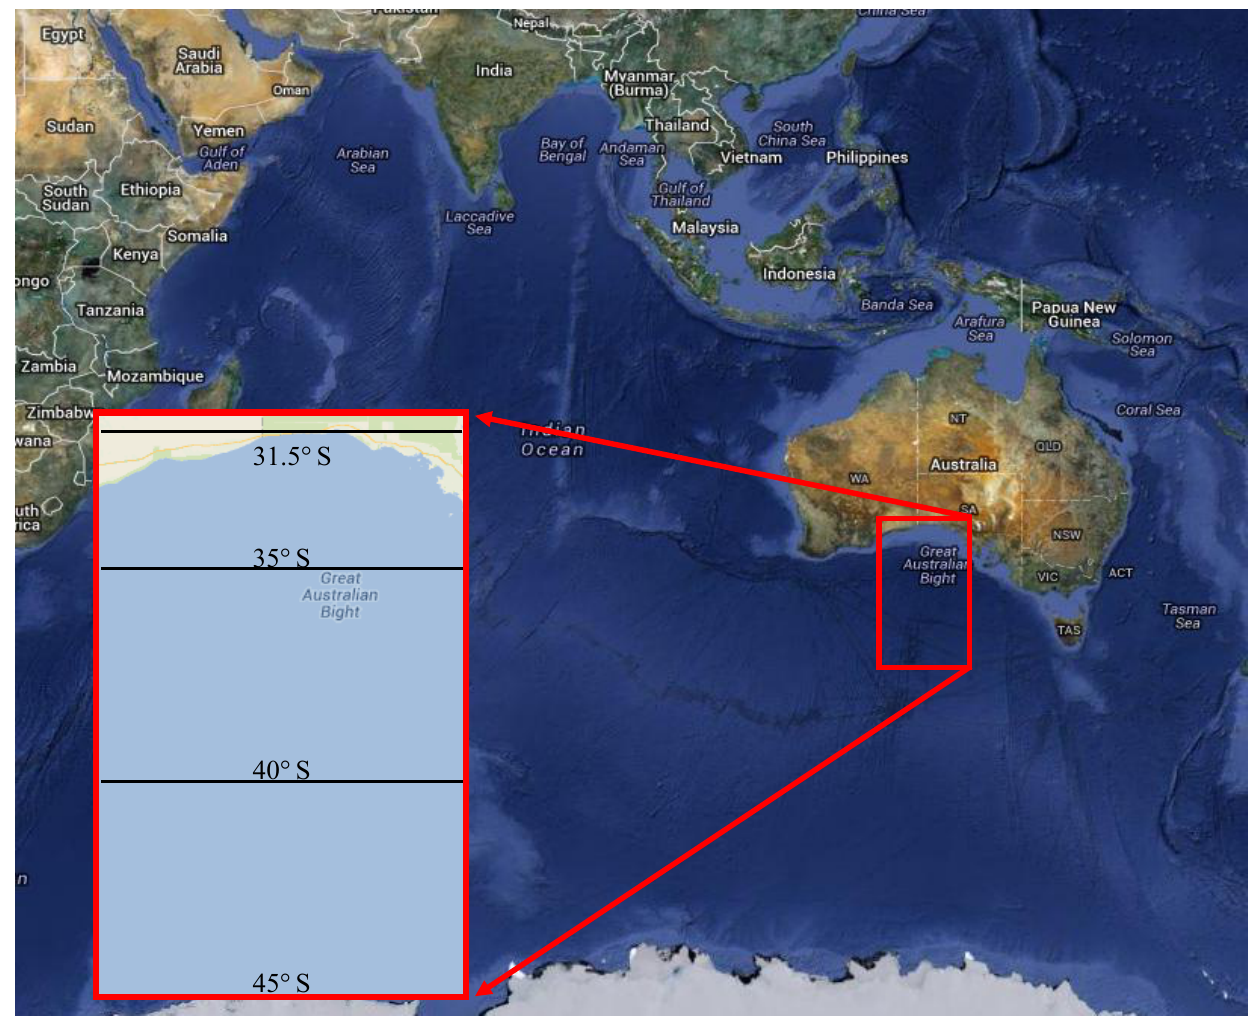
Figure 1. The domain under study in the Indian Ocean with a zoom in on the longitude band of 124.5 ◦ –134.5 ◦ E, where altimetry data are analyzed (reproduced from Google